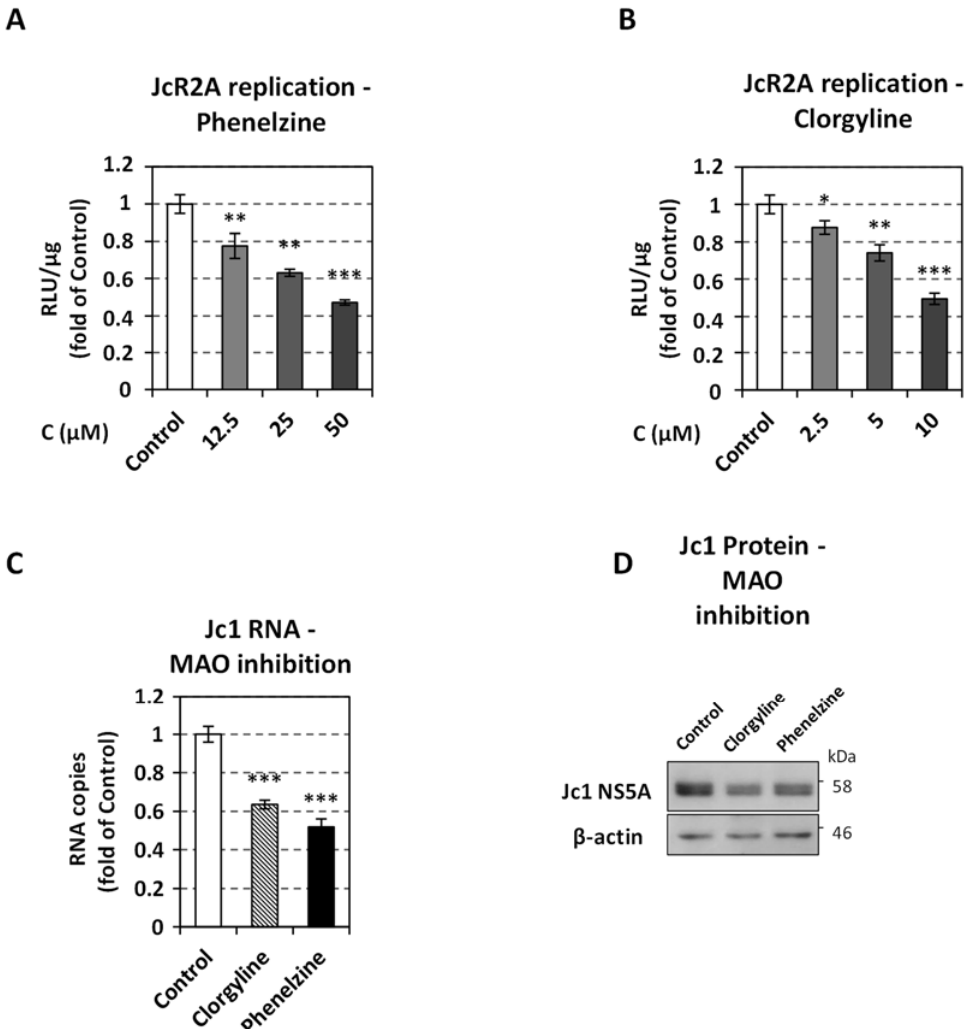
Figure 5. Effect of MAO inhibition on HCV replication. ( A , B ) Huh7.5 cells were inoculated with JcR2A (MOI = 0.5) for 4 h and subsequently treated for 72 h with the indicated concentrations of phenelzine ( A ) or clorgyline ( B ), or mock-treated (Control). Virus replication-derived R-Luc activity was determined in cell lysates and expressed as RLU/ µ g of total protein amount. ( C ) Huh7.5 cells were inoculated with Jc1 (MOI = 1) for 4 h and subsequently treated for 72 h with 10 µ M clorgyline, 50 µ M phenelzine, or mock-treated (Control). Viral positive-strand RNA levels were quantified by RT-qPCR and YWHAZ mRNA was used for normalization. ( A – C ) Values from infected non-treated cells were set to one. Bars represent mean values from three independent experiments in triplicate. Error bars indicate standard deviations. * p < 0.05, ** p < 0.01, *** p < 0.001 vs. Control. ( D ) Western blot analysis of HCV NS5A was performed in lysates of the Jc1-infected cells treated for 72 h with 10 µ M clorgyline, 50 µ M phenelzine, or mock-treated (Control). β -actin was used as loading control. A representative experiment of three independent repetitions is shown.